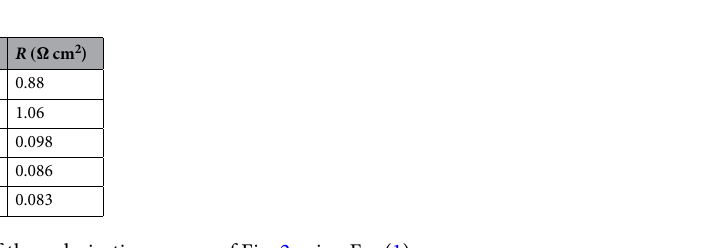
Table 1. Fitting parameters of the polarization curves of Fig. 2 using Eq. (1).